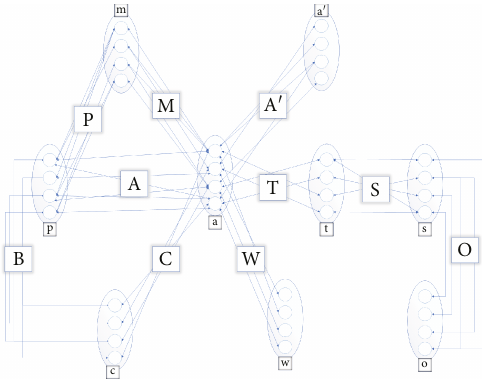
Figure 1: Illustrative network representation of a production system. The de fi nitions of the symbols are given in Table